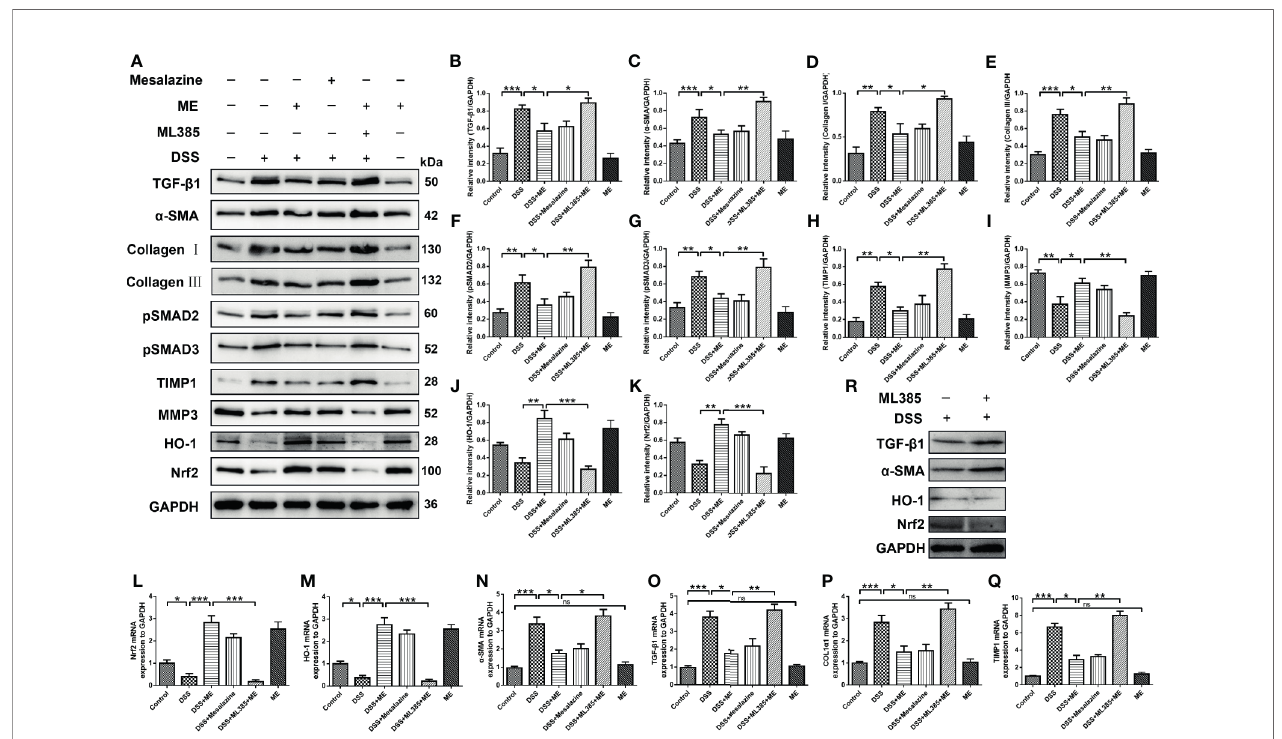
FIGURE 4 | ME suppresses in fl ammation-associated intestinal fi brosis by suppressing TGF- b 1/SMADs pathway via upregulating Nrf2 expression. Mice were allocated to six groups (n=8 per group). (A) Effects of ME on TGF- b 1/SMADs signaling pathways and Nrf2 pathway in DSS-induced chronic colitis. Representative data are shown in (A) . The relative protein intensities (B – K) were normalized to GAPDH. (L – Q) mRNA expression levels of the fi brosis markers were detected and normalized to GAPDH. (R) The inhibitor ML385 aggravated the colitis. The data are presented as mean ± SD. ∗ P < 0.05, ∗∗ P < 0.01, and ∗∗∗ P < 0.001; ns, no signi fi